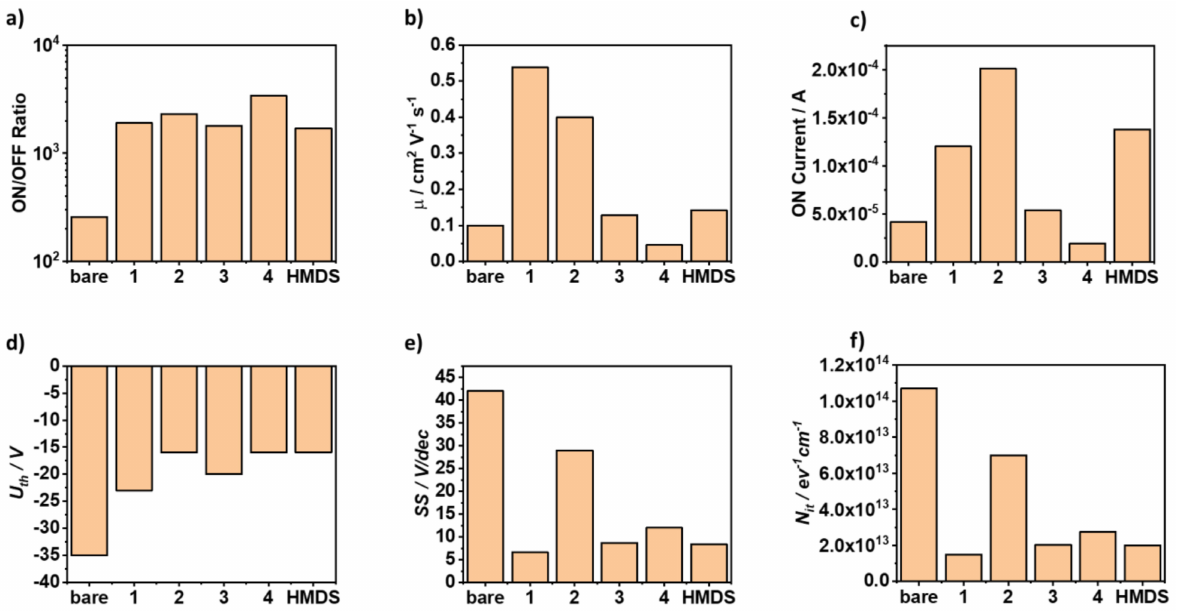
Figure 7. Bar charts comparing the ON/OFF ratio ( a ), charge carrier mobility ( b ), ON current ( c ), threshold voltage ( d ), subthreshold swing ( e ), and density of the interface traps ( f ) determined for selected OFETs with bare oxide BQMI compounds 1–4 or HMDS dielectric surface